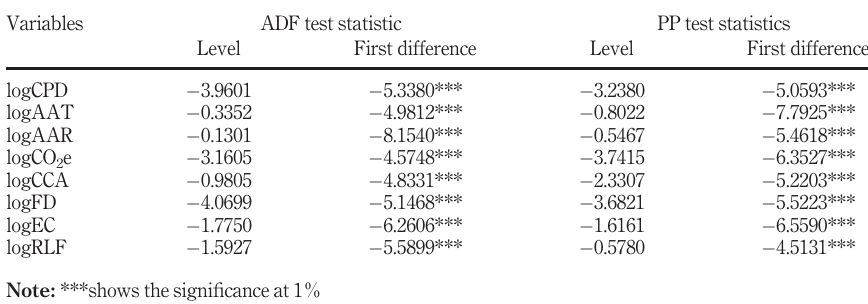
Table 1. Unit root test